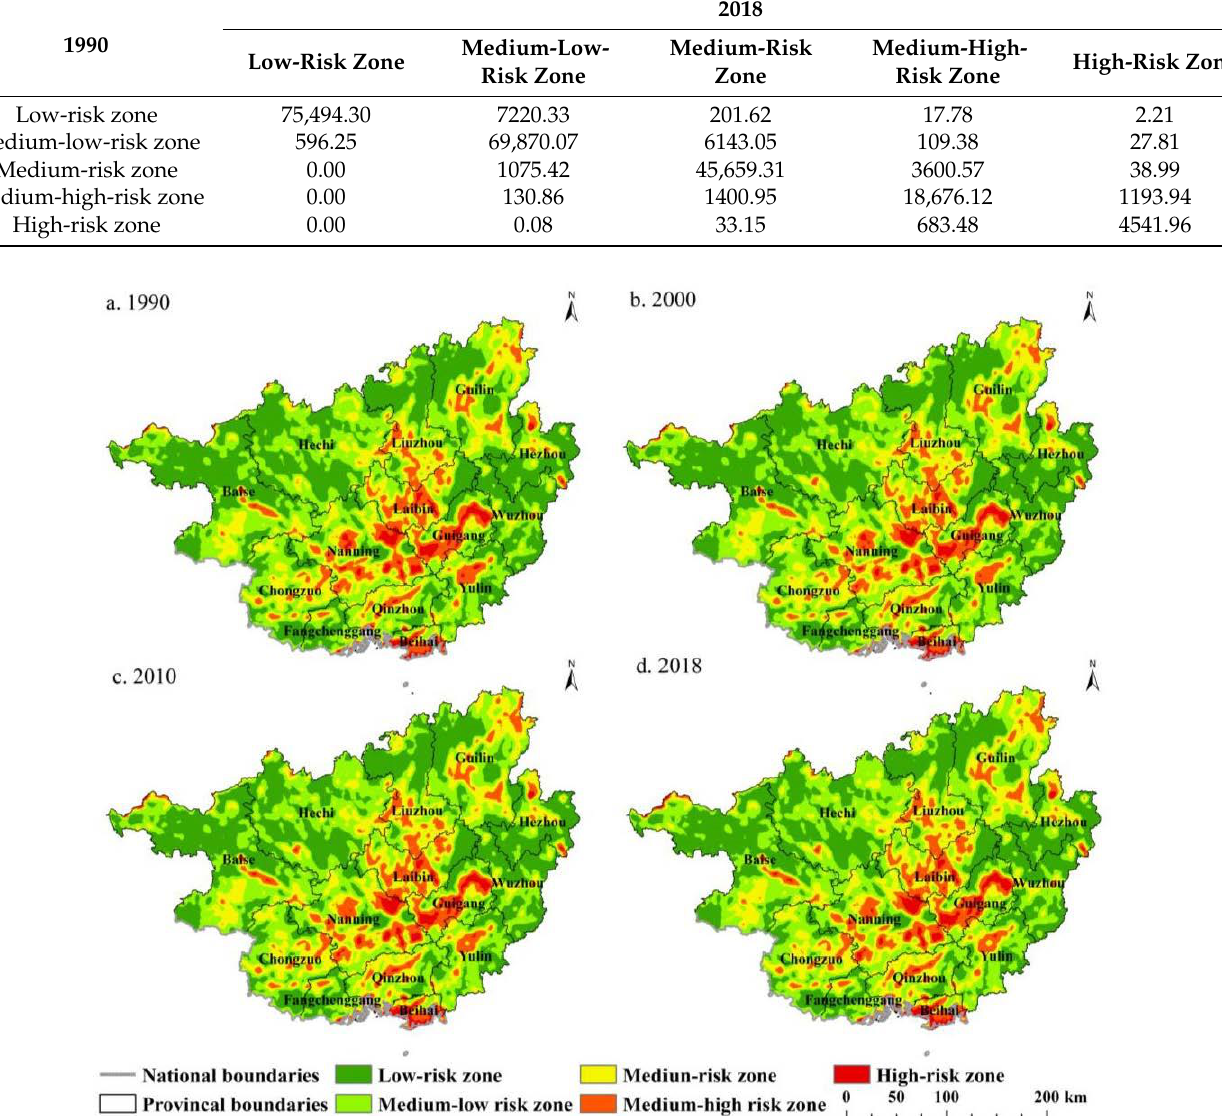
Table 8. Transfer matrix of landscape ecological risk zones (km 2 ) during 1990–2018.